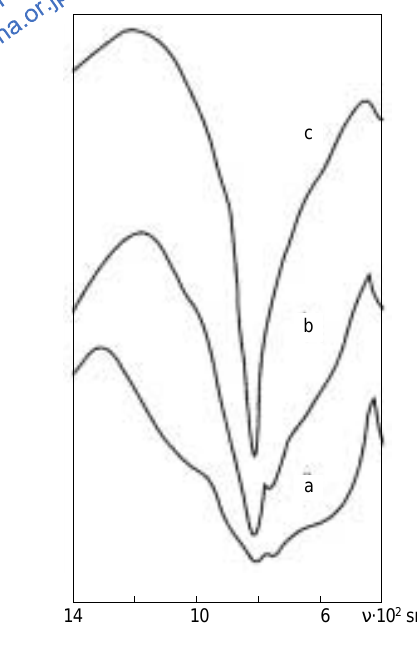
Fig. 19 IR spectra of an initial mixture of barium peroxide with WO 3 (a), after its mechanical activation for 10 s (b) and 1 min. (c).